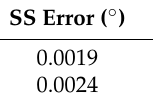
Table 6. Simulation dynamics responses of SAMA exoskeleton.